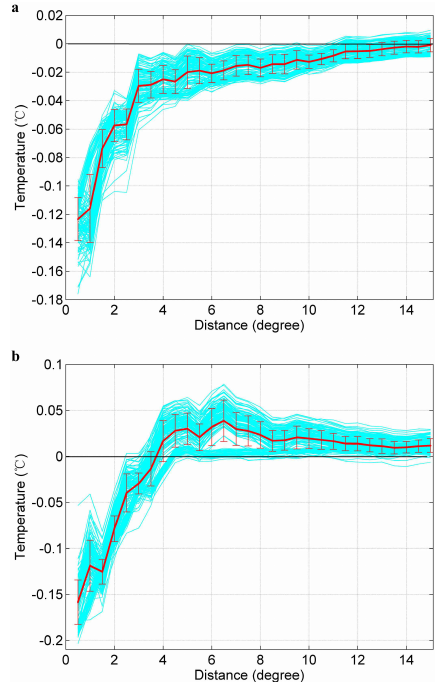
Figure 13. Two-hundred estimates (in cyan) of 0–1200m column- averaged temperature as a function of distance across the storm track, based on randomly sampling 90% of the Argo pairs for (a) TS/TD and (b) hurricanes, respectively. The mean and SDs are highlighted as the red line and error